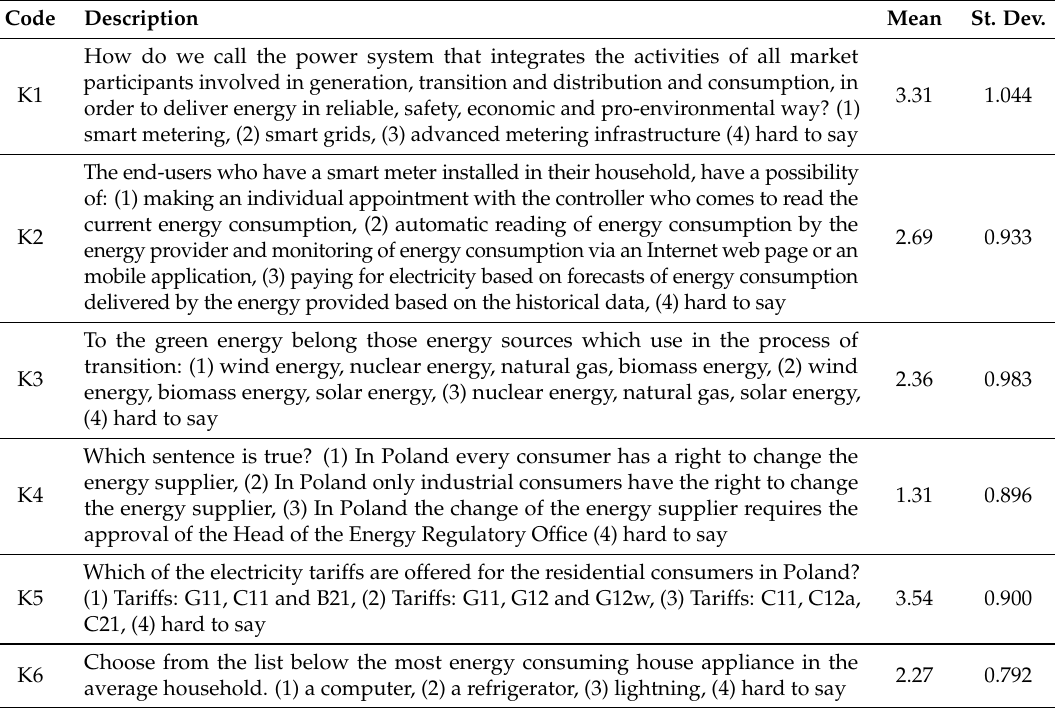
Figure 3. The distribution of positive and negative statements regarding four phases of adoption towards SMP (note: for stage F1 positive answers mean lack of agreement to the statement). Table 4. Knowledge regarding electricity